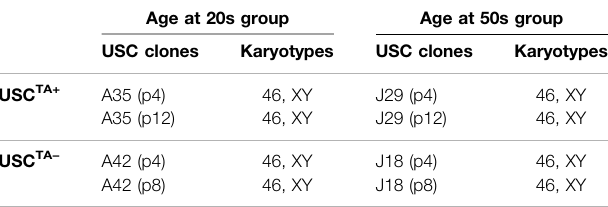
TABLE 5 | Conventional karyotypes of USC TA+ and USC TA- clones in the 20- and 50-years age groups at early and late passages. Age at 20s